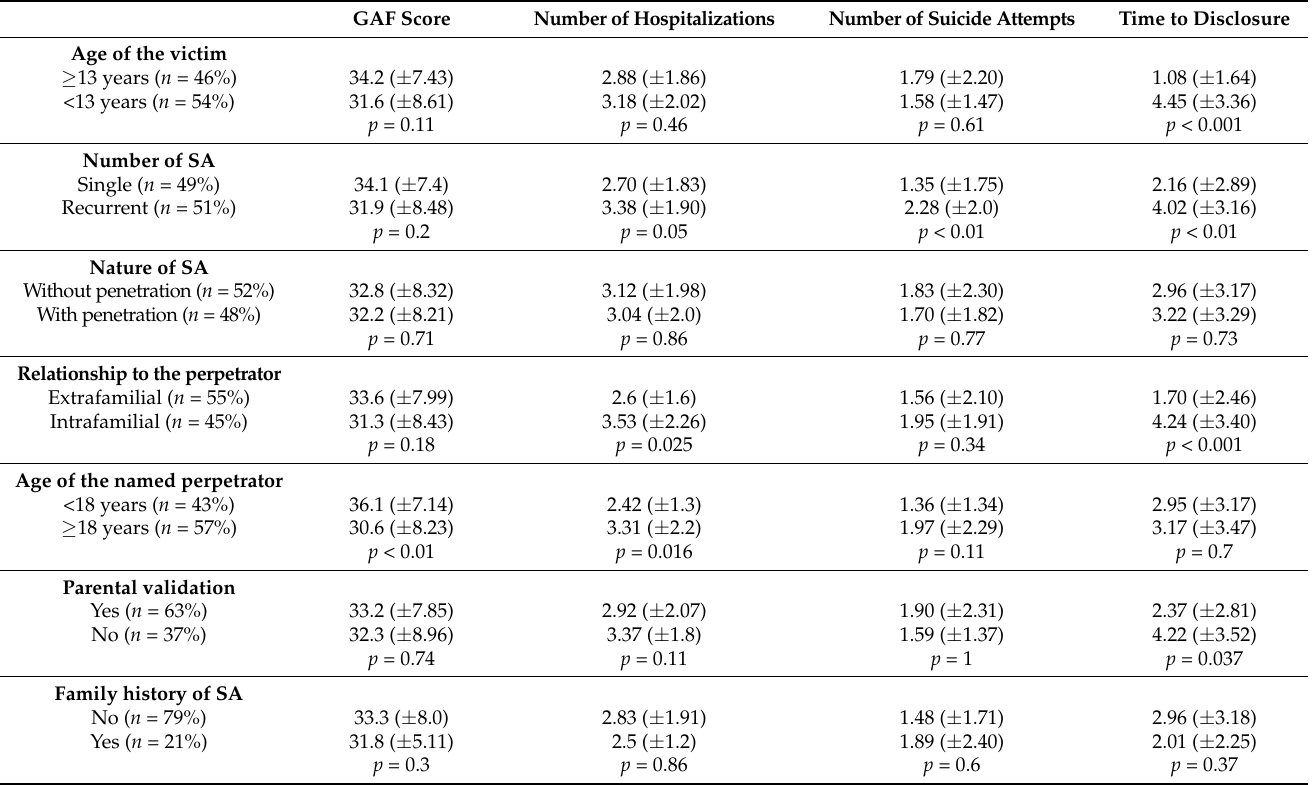
Table 1. Correlations between characteristics of sexual abuse and medical severity as well as time to disclosure (GAF: Global Assessment of Functioning scale; SA: Sexual abuse). GAF Score Number of Hospitalizations Number of Suicide Attempts Time to